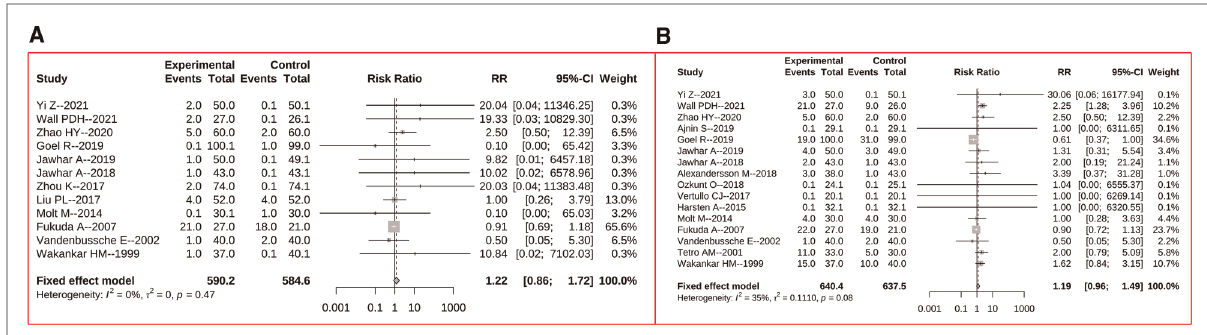
FIGURE 6 Forest plots for comparisons of risk of DVT ( A ) and risk of all complications ( B ) between the tourniquet (experimental) and non-tourniquet (control) groups. The I 2 were 0% and 35%, and fi xed-effect models were selected,